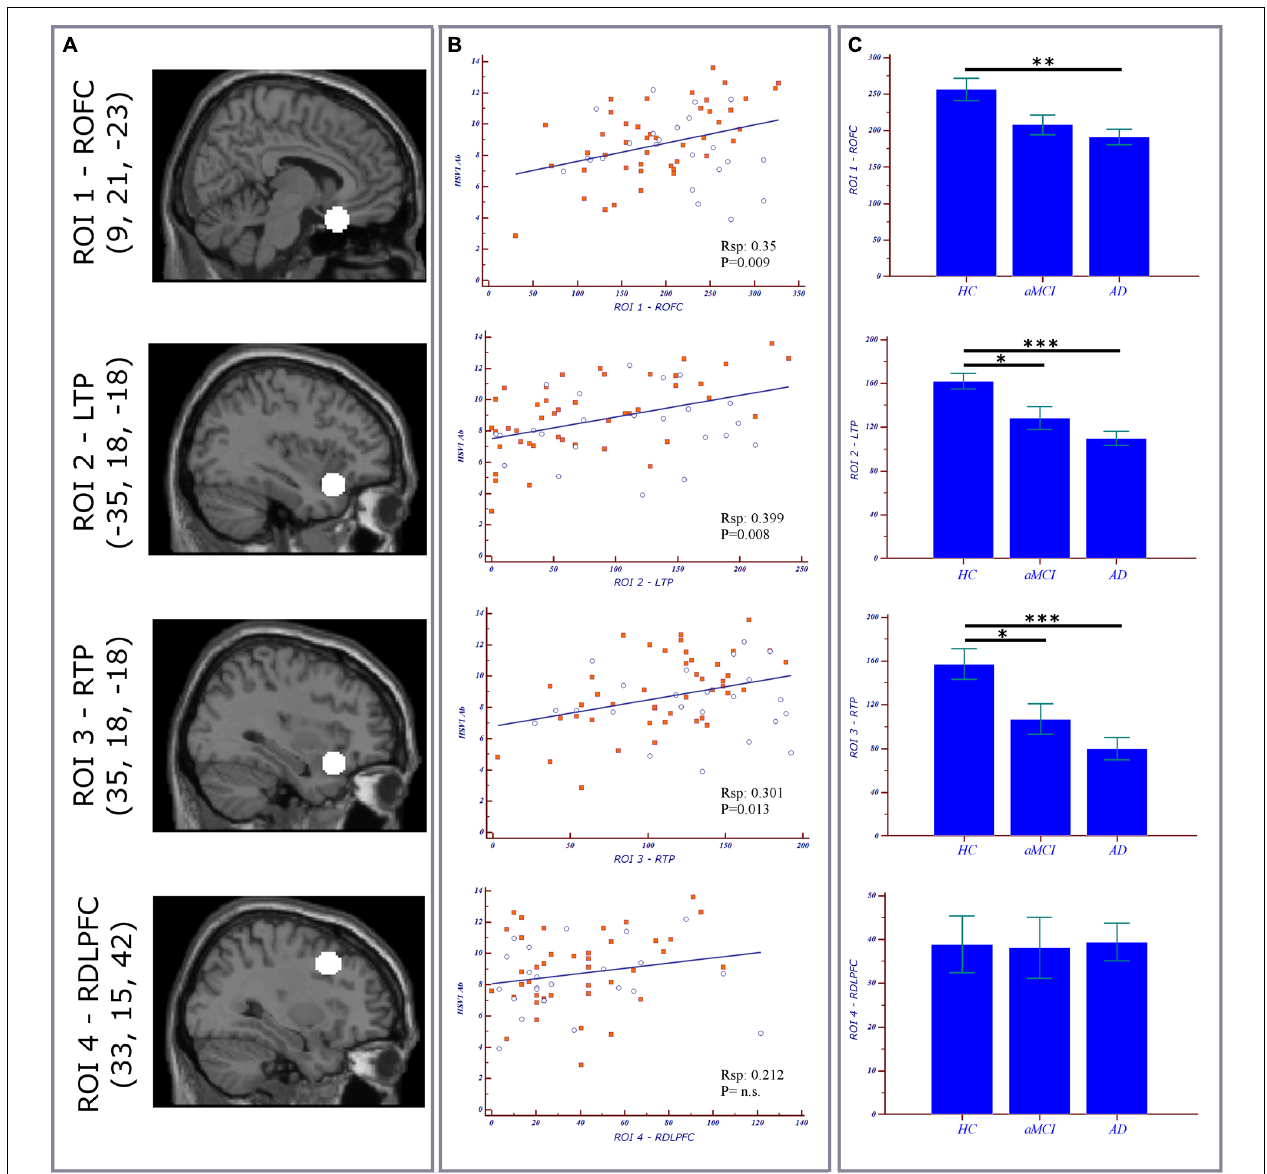
groups. Post hoc results are illustrated (* p < 0.05; ** p < 0.01; *** p < 0.001). ROFC, right orbitofrontal cortex; LTP, left temporal lobe; RTL, right temporal lobe; RDLPFC, right dorsolateral prefrontal cortex; AD, Alzheimer’s disease; aMCI, amnestic mild cognitive impairment; R Sp , Spearman correlation